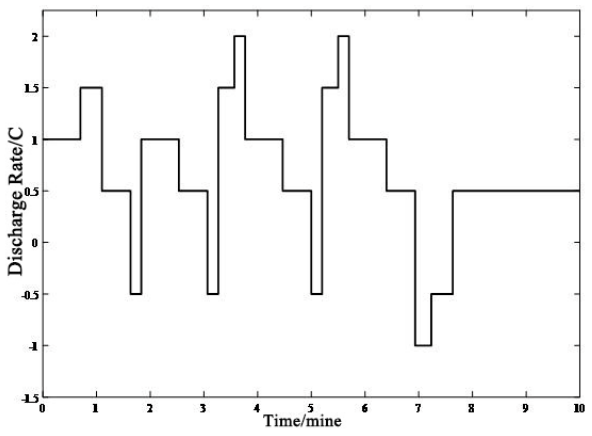
Figure 8. Simulated working conditions.